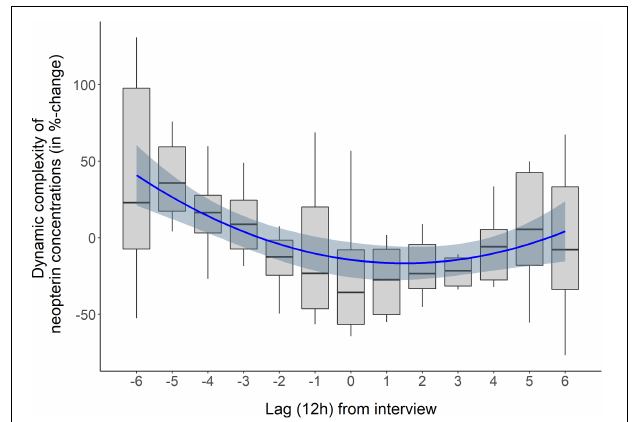
FIGURE 2 | (A) Autocorrelation function (ACF) of Dynamic Complexity (DC) of urinary neopterin per creatinine up to 21 lags. Coefficients (bars) reaching the upper or lower confidence limits (dotted lines) are significant at p < 0.05. (B) Periodogram of DC of urinary neopterin per creatinine.